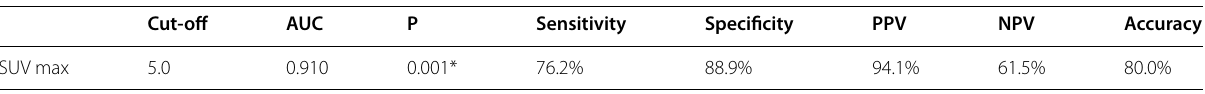
AUC Area Under the Curve; PPV Positive predictive value; NPV Negative predictive value; p probability; *, Significance <